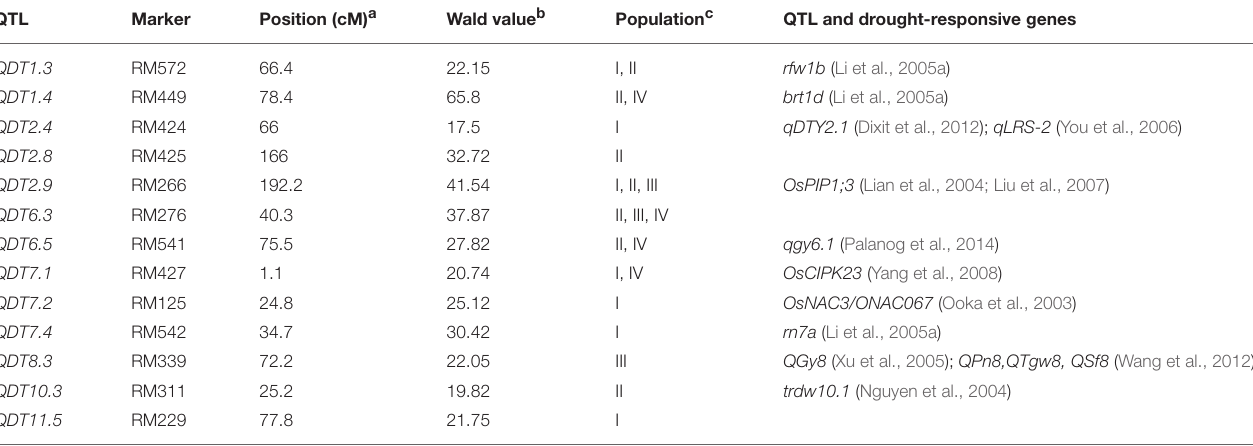
TABLE 4 | Thirteen QTL associated with drought tolerance identified by the segregation distortion mapping method in DT introgression lines selected from four backcross populations. QTL Marker Position (cM) a Wald value b Population c